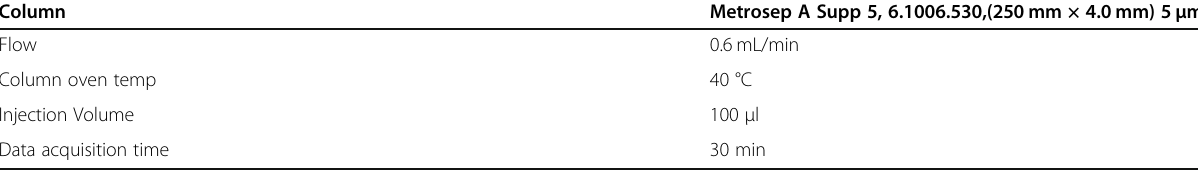
Table 1 Chromatographic conditions